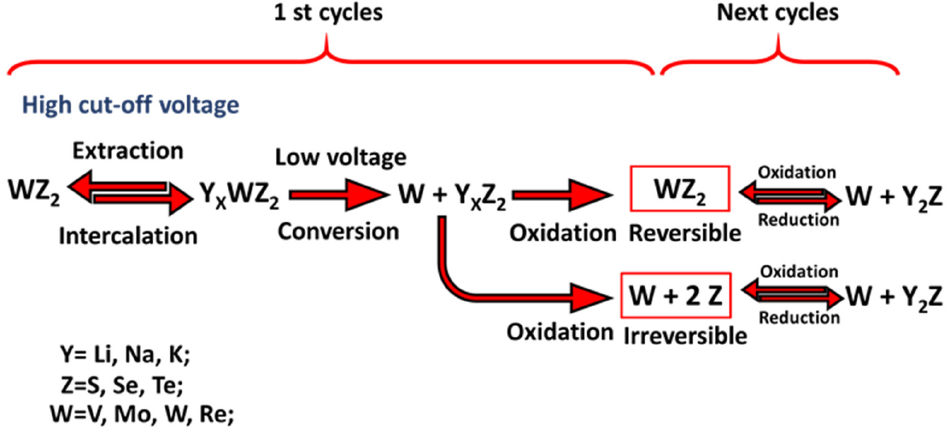
Figure 5. Schematic of electrochemical storage mechanisms for WZ 2 in rechargeable batter- ies. Reprinted (adapted) with permission from Reference [115], Copyright (2020), Royal Society of